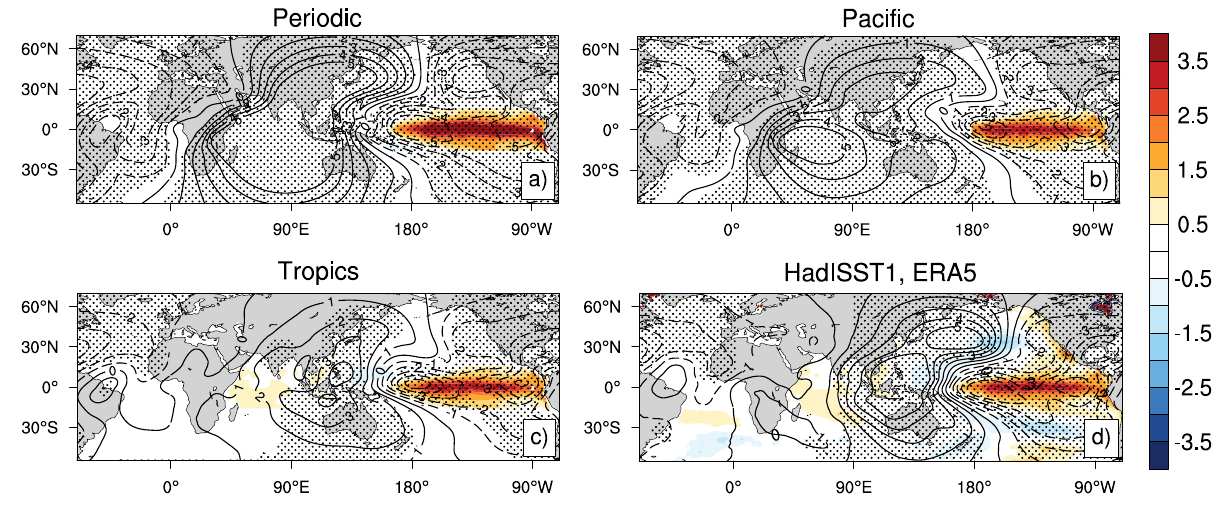
Figure. 1. Composite differences of SST anomalies (shading; unit: K), and 200 hPa velocity potential anomalies in D(0)JF(1) (contours; unit: m 2 s −1 , scaled by 10 6 ) between El Niño and La Niña events for the Periodic experiment ( a ), the Pacific experiment ( b ), the Tropics experiment ( c ), HadISST1 and ERA5 reanalysis ( d ): El Niño events: 1982, 1987, 1991, 1997, 2002, 2009; La Niña events: 1984, 1988, 1999, 2000, 2007, 2010 for the Pacific experiment, the Tropics experiment, and the observations. Negative values (dashed lines) indicate anomalous upward motion and positive values (solid lines) indicate anomalous downward motion. Stippling indicates a statistically significant difference at the 95% significance level for the 200 hPa velocity potential. Fig. 1 was generated using NCAR Command Language Version 6.5.0 (http:// dx. doi. org/ 10. 5065/ D6WD3